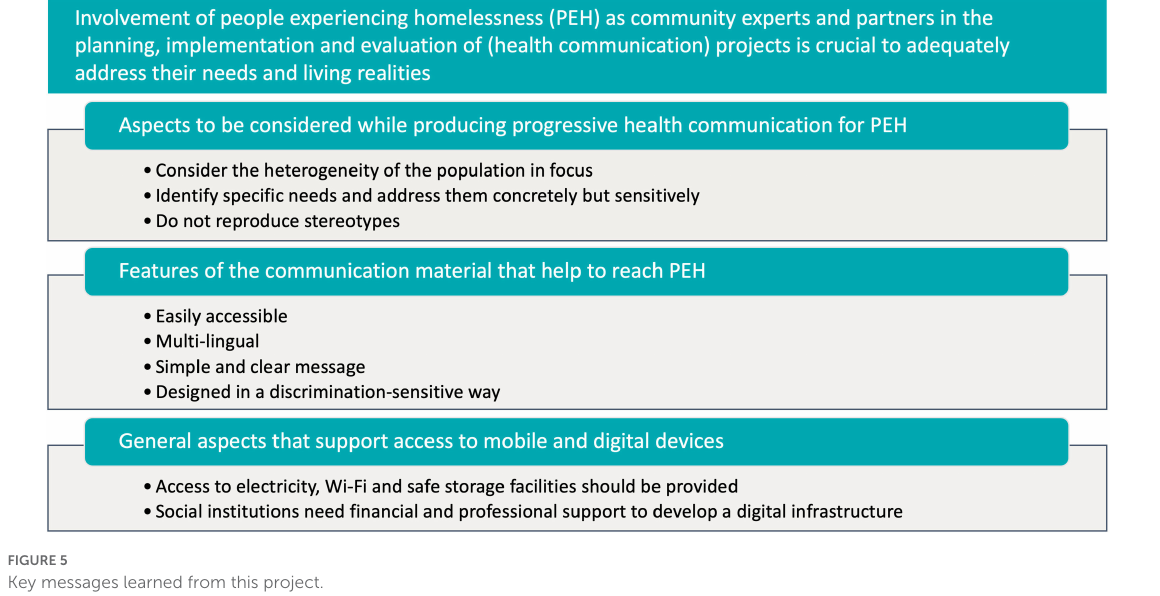
FIGURE5 Key messages learned from this